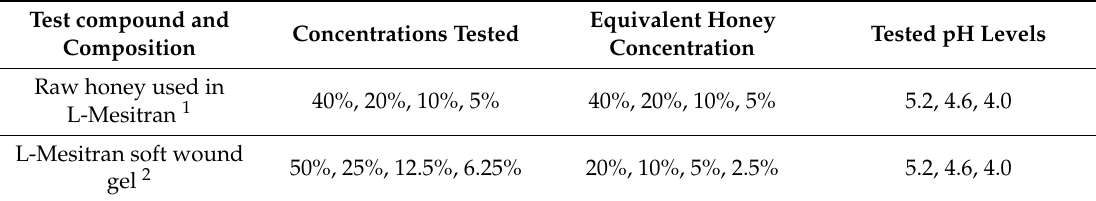
Table 1. Summary of tested compounds, their composition, and test